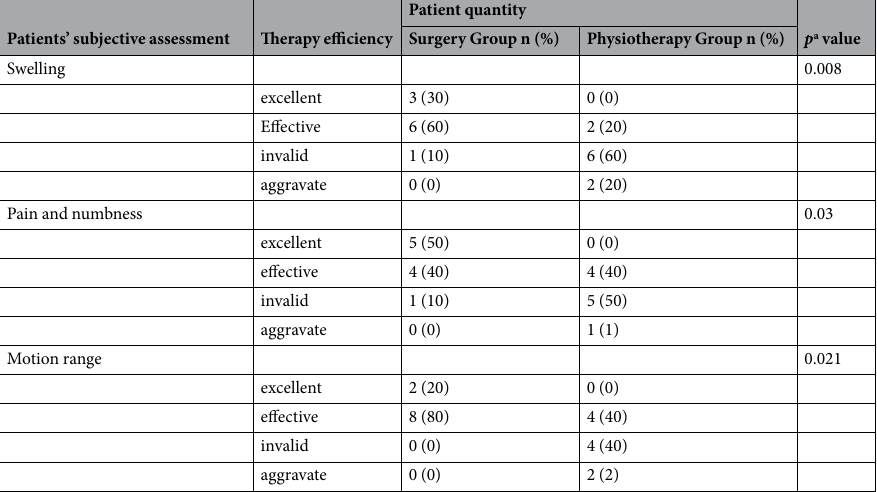
Table 3. Questionnaire of patients’ affected limb sensations and motion range changes after therapy. a p-value is based on Fisher’s exact